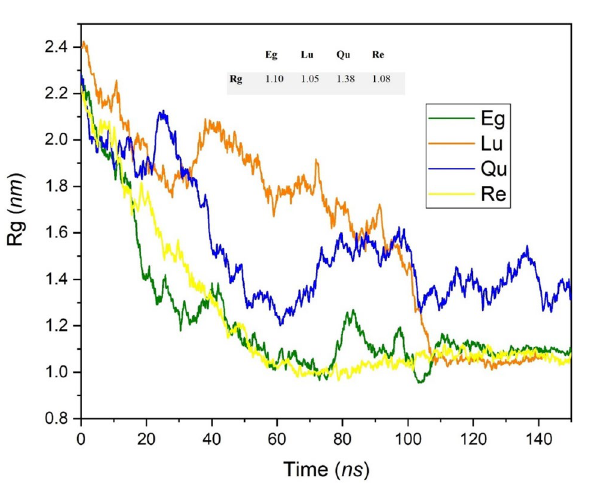
Figure 15. Radius of gyration (Rg,x) of the investigated complexes as function of simulation